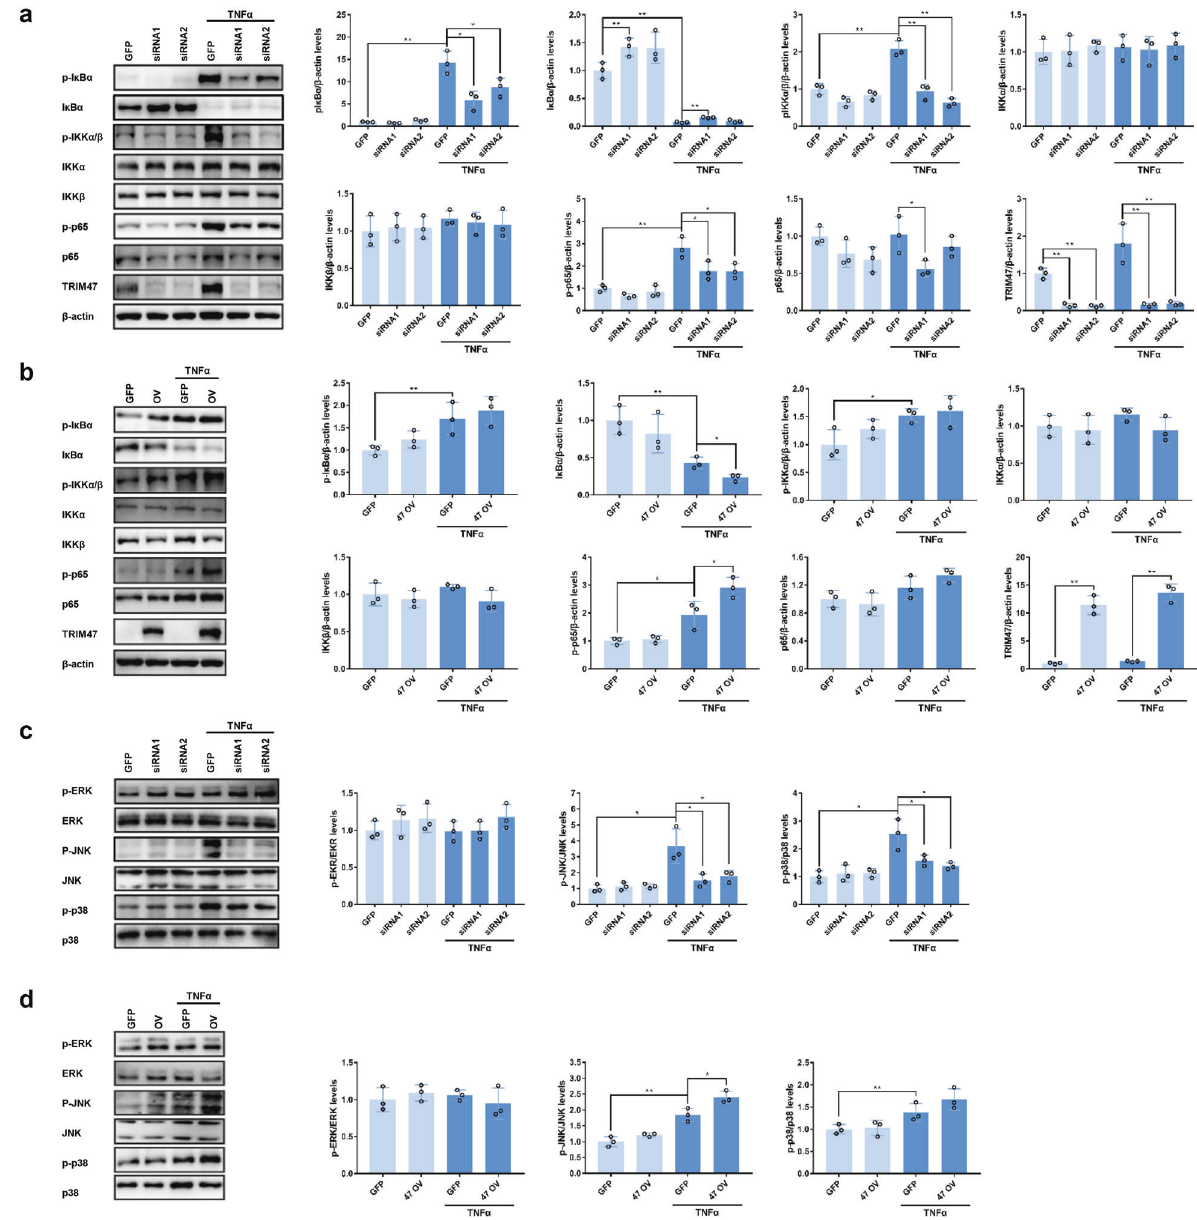
Fig. 6 TRIM47 modulates endothelial activation through NF- κ B and MAPK signaling pathways. Representative images of the immunoblots of p-I κ B α , I κ B α , p-IKK α / β , IKK α , IKK β , p-p65, p65, TIRM47, and β -actin after TNF α stimulation detected by western blot and the relative quantitation of the protein levels in ( a ) TRIM47-knockdown and ( b ) TRIM47-overexpressed HUVECs. Representative images of the immunoblots of p-ERK, ERK, p-JNK, JNK, p-p38, and p38 after TNF α stimulation detected by western blot and the relative quantitation of the protein levels in ( c ) TRIM47-knockdown and ( d ) TRIM47-overexpressed HUVECs ( n = 3, one-way ANOVA, * P < 0.05, ** P < (Fig. 6d). These results indicated that TRIM47-mediated endothe- lial activation might be related to the activation of NF- κ B and MAPK signaling pathways.